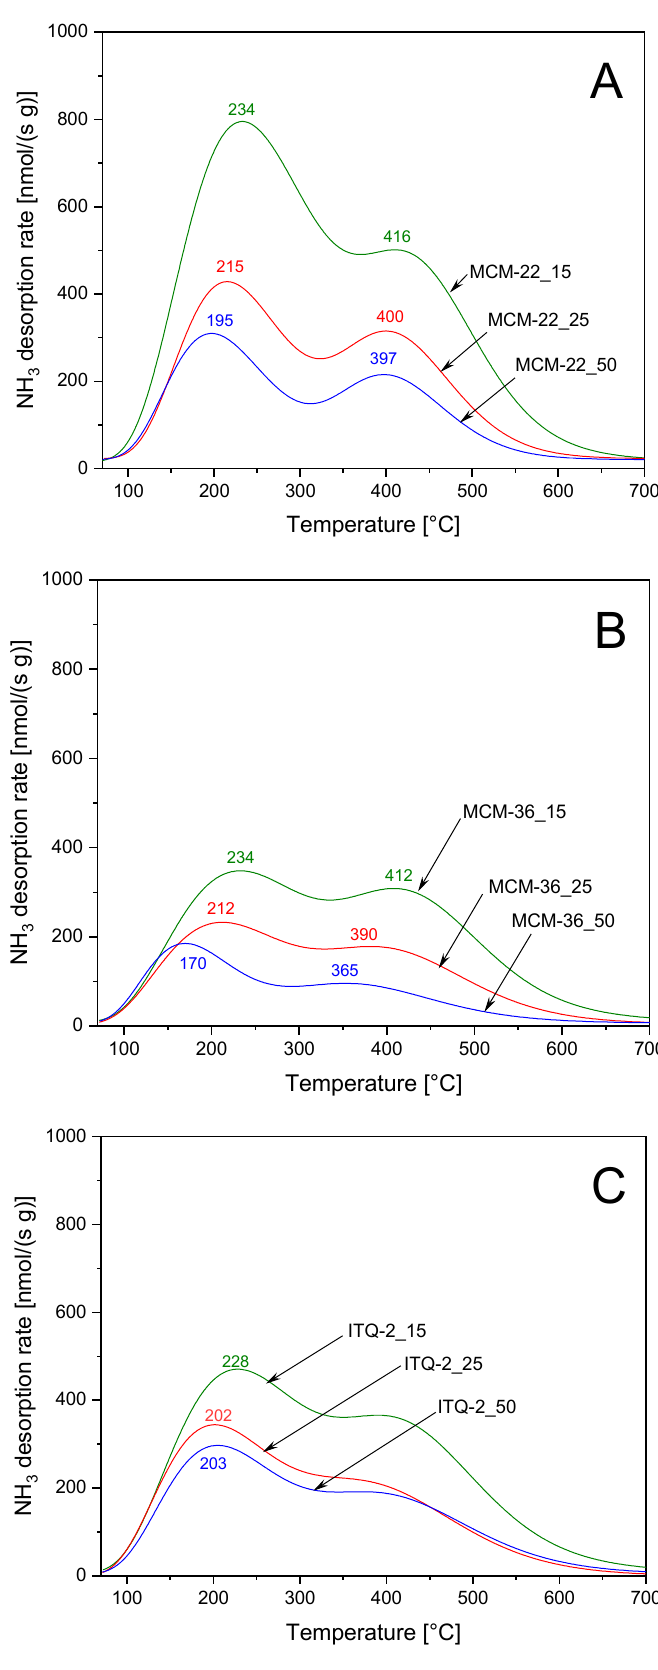
Figure 4. NH 3 -TPD profiles of MCM-22 ( A ), MCM-36 ( B ), and ITQ-2 ( C )